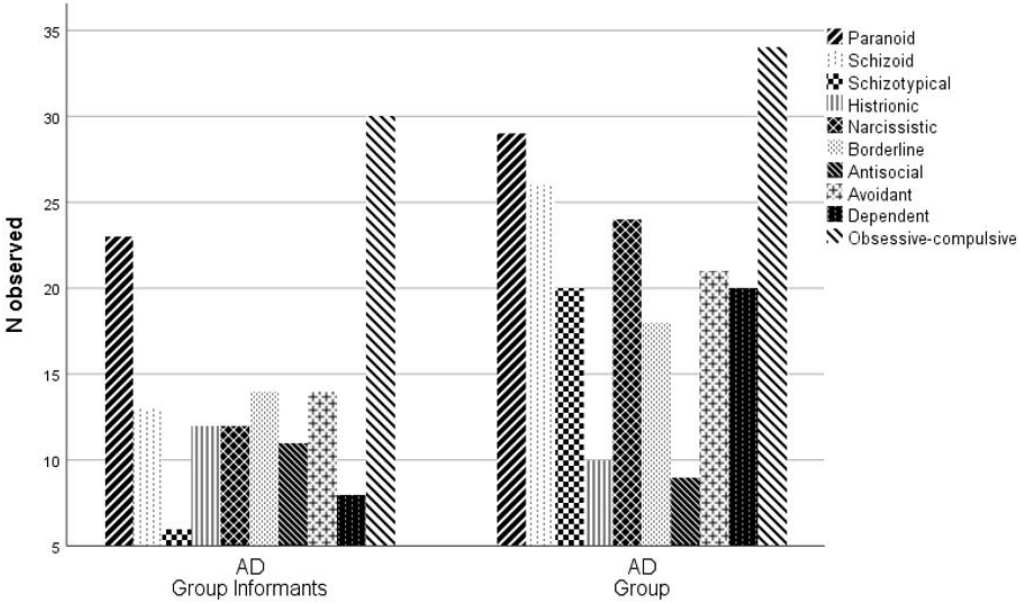
Figure 2. Bar graph of the observed distribution of the ten scales of the PDQ-4+ in AD Group Informants and AD Group.